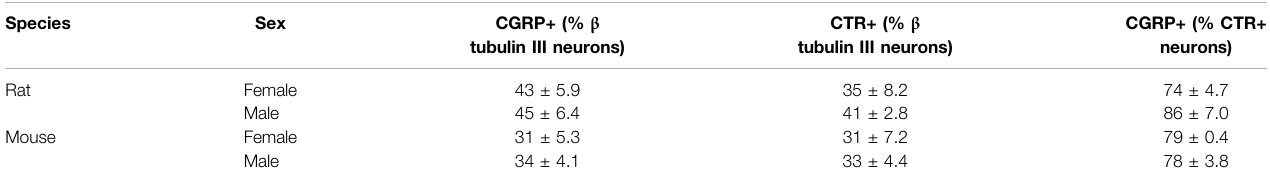
Data are the mean ± s.e.m, combined from three individual female or male rats or mice. Comparisons between females and males of the percentage of CGRP+ neurons, CTR+ neurons and percentage of CTR+ neurons that co-express CGRP in rats or mice were made by unpaired Student ’ s t -test. There were no signi fi cant differences.